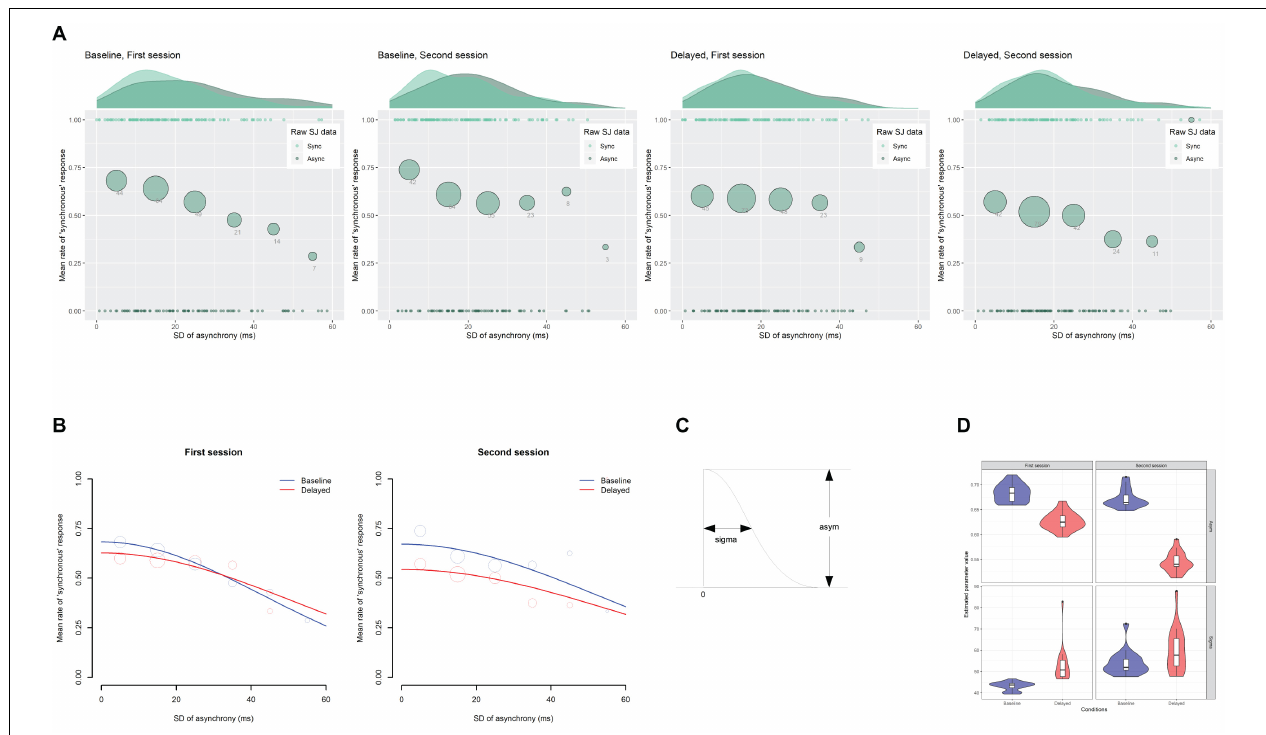
FIGURE 5 | Results from the analysis on a trial-by-trial basis about the simultaneity judgment (SJ) data under the computer-controlled trials against the SD of asynchrony. (A) Scatter plots of the raw SJ data against the SD of asynchrony that is pooled across participants for each condition in two sessions. The probability density of the data is displayed as a curve outside the plot. The mean rate of the “synchronous” responses against the six bins of the SD of asynchrony is displayed as a circle within the plot. The size of the circle reflects the number of observations in the bin, which is also indicated by the digit below the circle. (B) Fitted half-Gaussian functions of the SJ against the SD of asynchrony for each condition in two sessions. Mean rate of “synchronous” response against the binned SD of asynchrony was also displayed for reference. The size of the circle reflects the number of observations. (C) The asym and sigma are the parameters of the half-Gaussian representing height and width. (D) Violin plots with boxplots representing the distribution of the estimated parameters from the 18 jackknife replications of the fitting of the half-Gaussian function to the SJ against the SD of asynchrony.